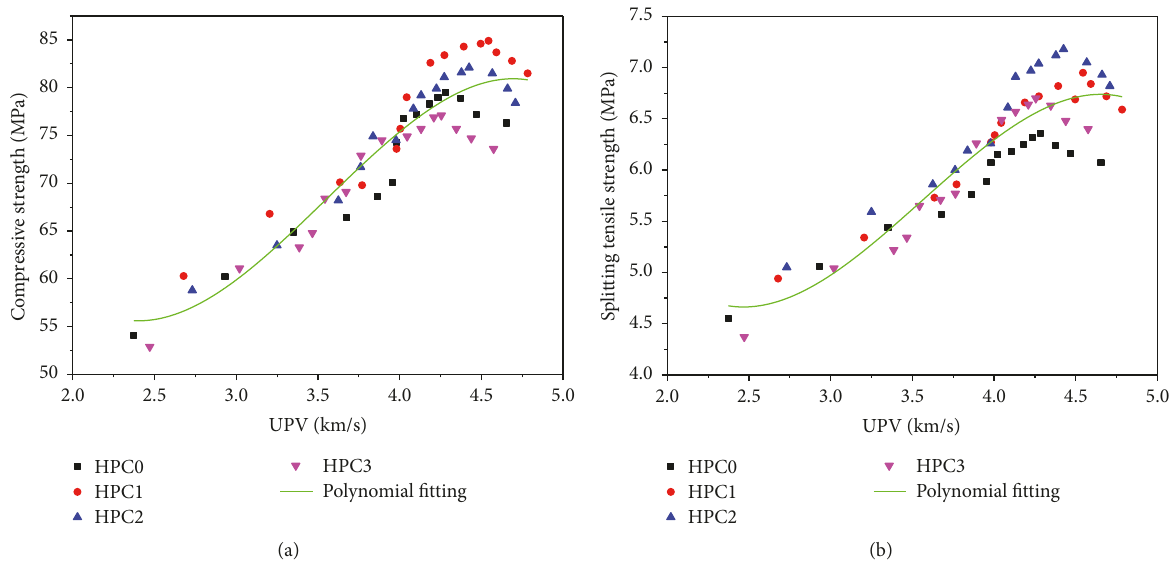
Figure 8: Relationships between strengths and UPV for HPCs: (a) compressive strength versus UPV and (b) splitting tensile strength versus UPV.